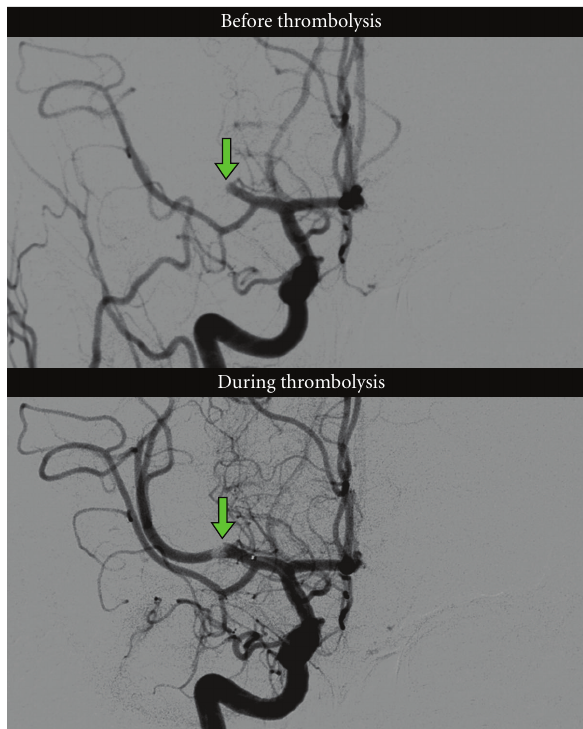
Figure 11: Case 4: DSA images from the right anterior cerebral circulation before recanalization showed an occluded right MCA M2-segment. During IA-thrombolysis partial revascularization was achieved with a remaining clot.